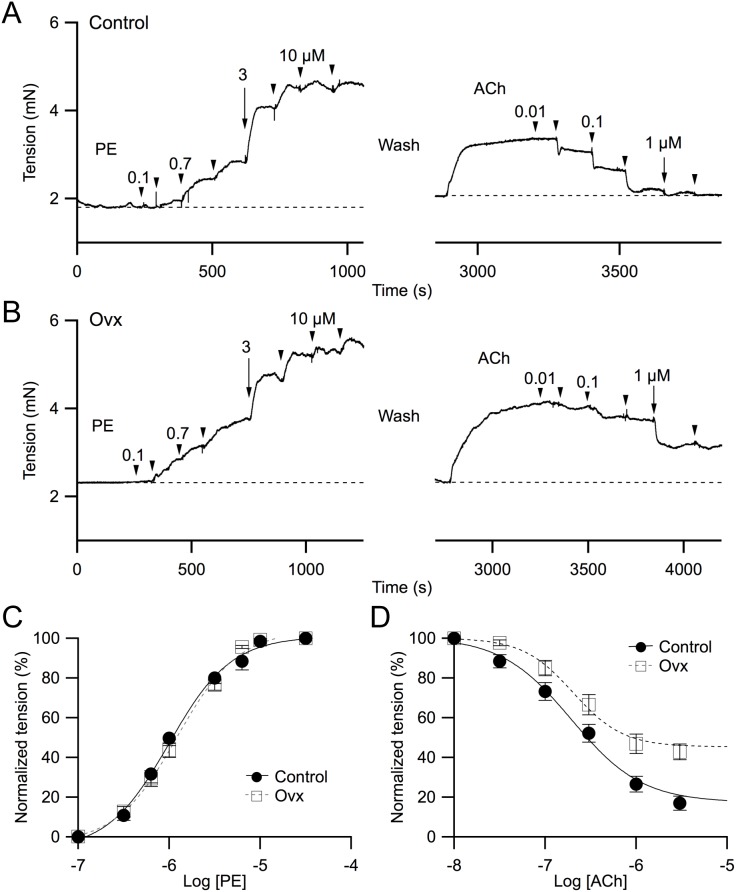
Ovariectomy reduces ACh-induced vasorelaxation.Representative force myograph traces showing isometric tension (mN) plotted against time (s) for both control (A) and ovariectomized (ovx; B) mesenteric vessels, and their concentration responses to both phenylephrine (PE; left panel) and acetylcholine (ACh; right panel). A and B: (left panel) Arrowheads and arrow markers show addition of different [PE] (from left to right: 0.1, 0.3, 0.7, 1, 3, 7, 10, and 30 µM); the arrow indicates the addition of 3 µM PE. (right panel) Following PE washout the vessels were ∼50% pre-contracted with PE and different [ACh] were added (markers from left to right: 0.01, 0.03, 0.1, 0.3, 1, 3 µM), with the arrow indicating 1 µM ACh. Normalized concentration-response of PE (C) and ACh (D) for both control (solid circles) and ovx (empty squares) vessels. Data were fitted with sigmoidal curves for both control (solid lines) and ovx (dotted lines) vessels. Both plots were normalized to the maximum PE-induced tension.